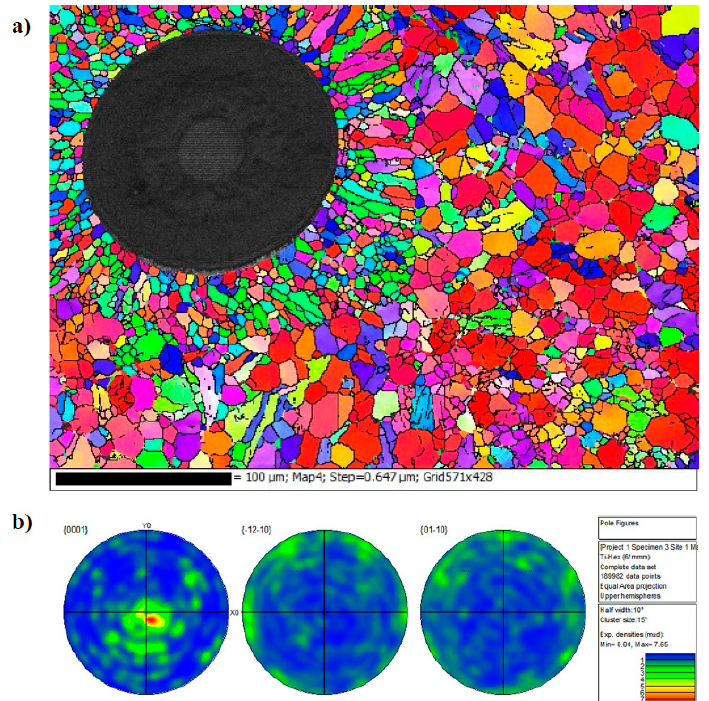
Figure 5. EBSD phase map showing primary α in red with intergranular β in blue.